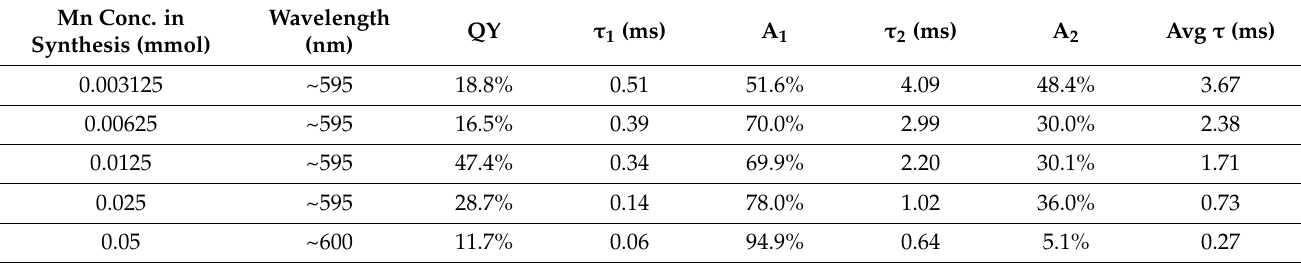
Table 2. Effects of Mn concentration on optical properties of Mn:CuGaS-ZnS (Cu/Ga = 1/8) NCs. Mn Conc.